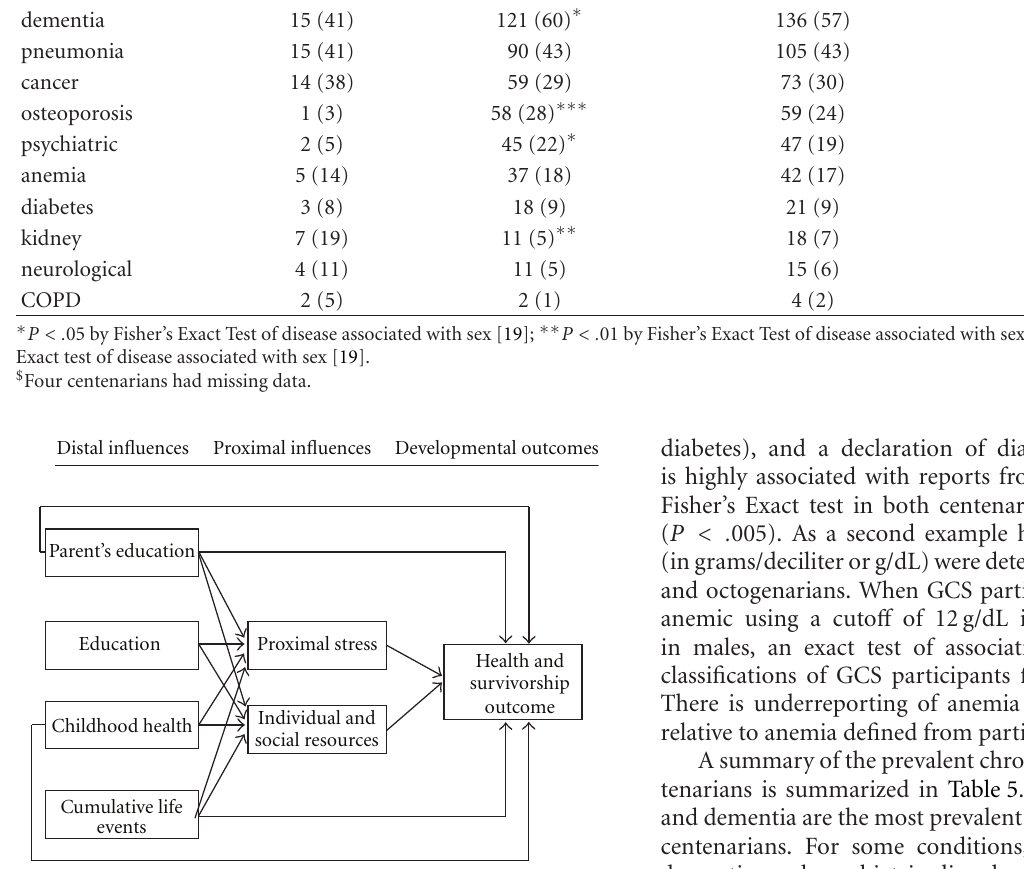
Figure 3: Developmental Adaptation: The influence of distal variables (e.g., cumulative life events, parents’ education, education, and childhood health) on adaptational outcomes in very late